Question: How would you classify this visualization?
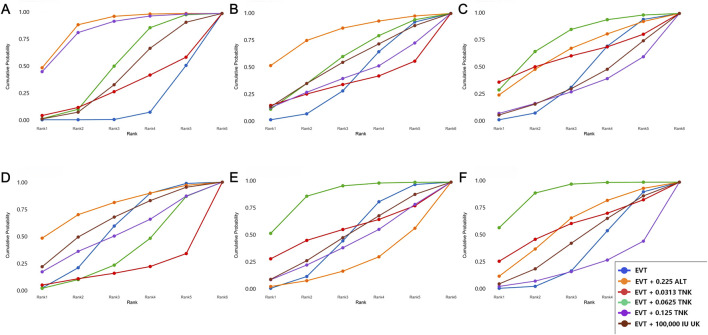
Answer: line